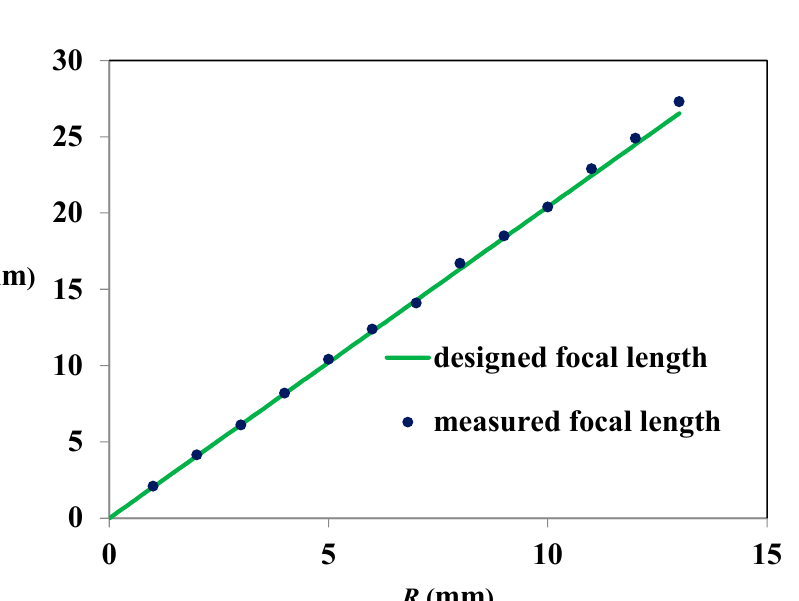
Figure 13. Relation of focal length ( f ) and radius of curvature ( R ).